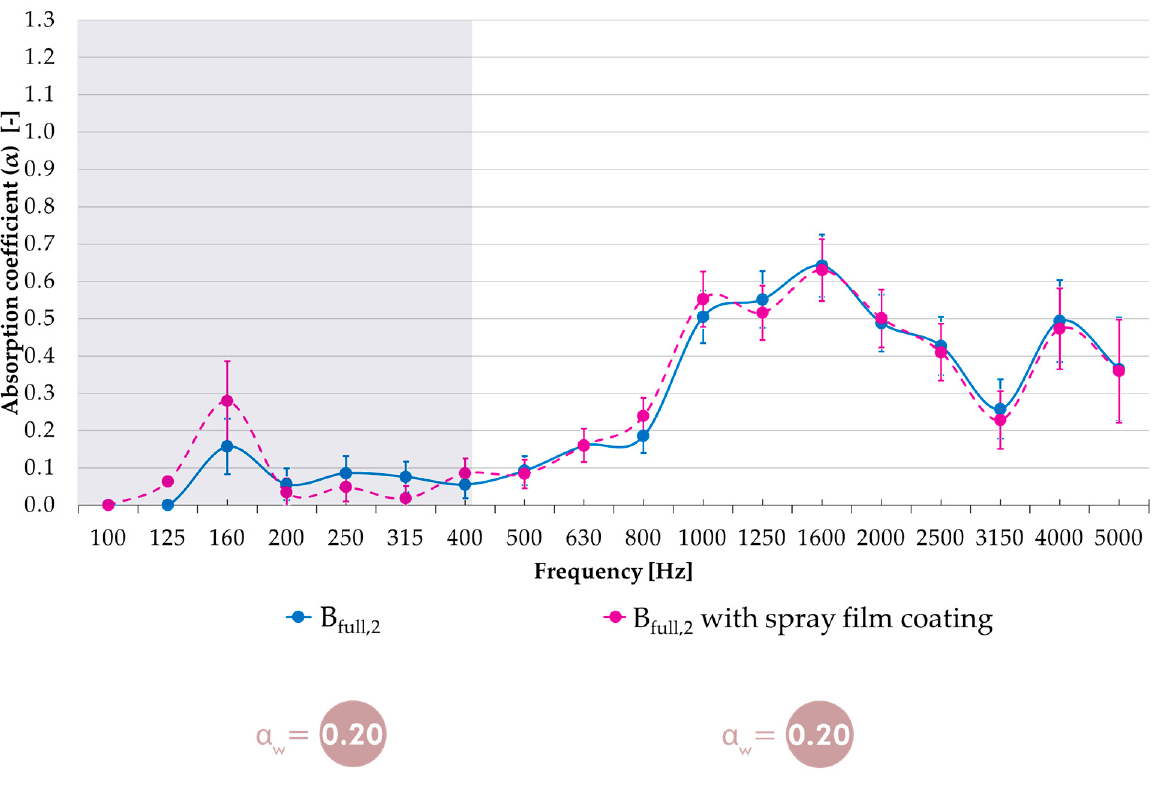
Figure 16. The obtained random incidence sound absorption coefficients from B full,2 and B full,2 with the spray film coating and the standard deviations.